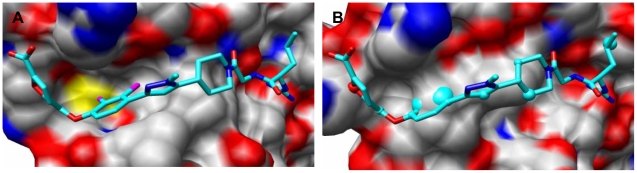
Conformational changes in IL-2.(A) IL-2 holo conformation bound with the co-crystallized ligand FRH (1py2). (B) The same ligand is superimposed on the apo conformation of the protein (1z92), highlighting the conformational changes. Molecular images were generated with UCSF Chimera [42].